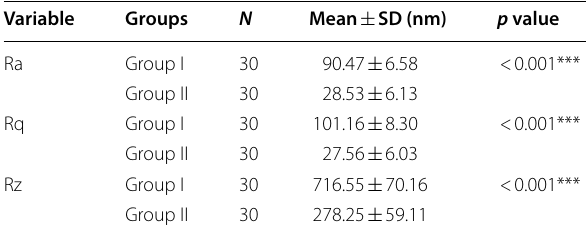
***Statistically significant